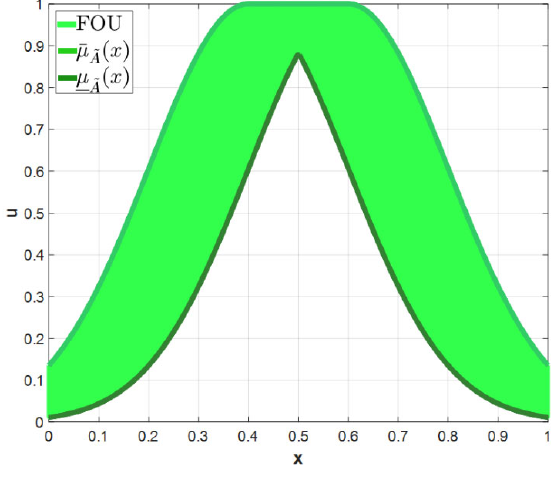
Figure 3. Gaussian type ‐ 2 MF.